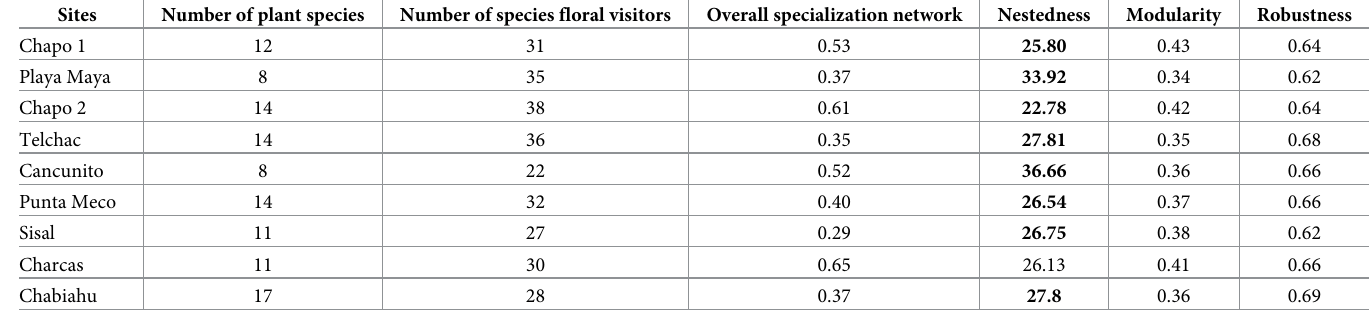
Table 2. Number of plants, floral visitor species and plant-floral visitor interaction network metrics at nine sites across the north coast of the Yucatan Peninsula. Significant values for nestedness and modularity are shown in bold (P < 0.05). Sites are ordered according to proportion of alien flower abundance (see Table 1). Sites Number of plant